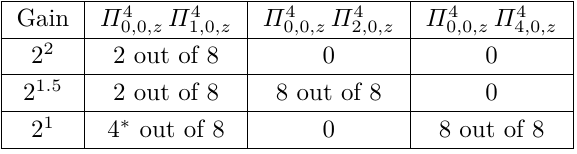
Table 11: Cases of 2 linearized bits matching 3-bit output